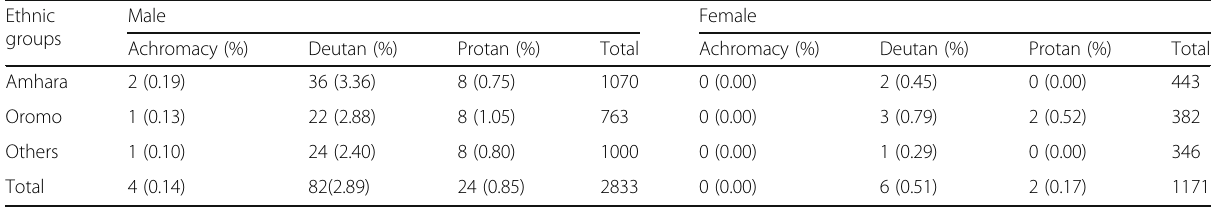
Table 2 Phenotypic frequency of achromacy and the different types of CCVD among male and female students of various ethnic groups in Hawassa University, Ethiopia Ethnic